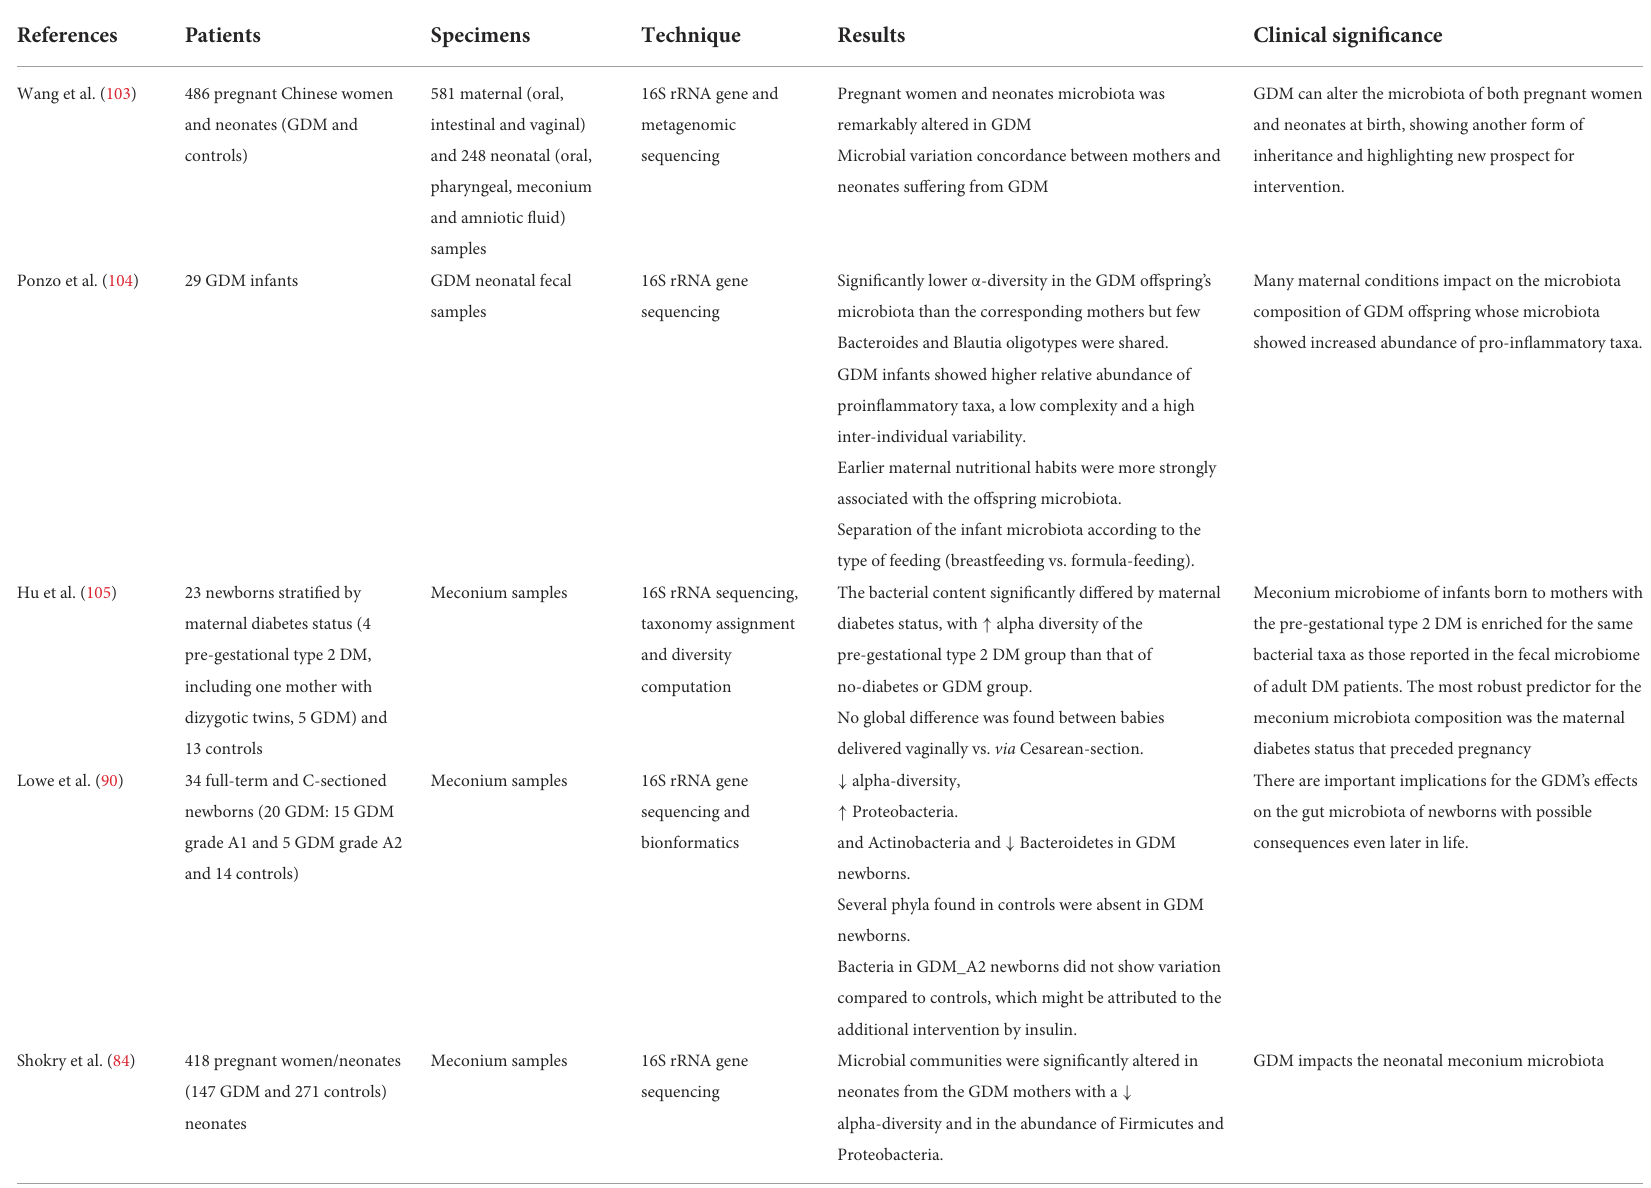
TABLE 3 Studies investigating GDM neonatal